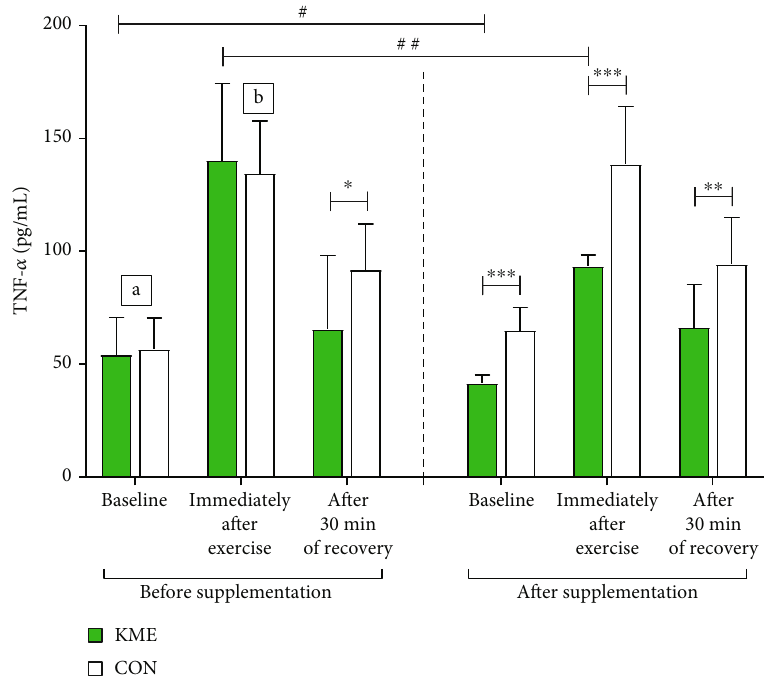
Figure 5: Changes in tumor necrosis factor alpha levels during the 2,000 m rowing ergometer exercise trials before and after supplementation ( means ± SD ). a Interaction e ff ects at the baseline level. b Interaction e ff ects immediately after exercise. # p < 0 : 05 and ## p < 0 : 01 before vs. after; ∗ p < 0 : 05 , ∗∗ p < 0 : 01 , and ∗∗∗ p < 0 : 001 KME vs.